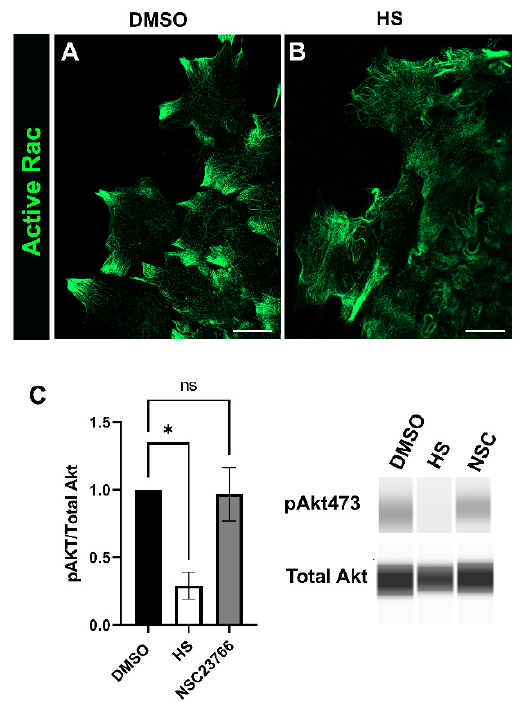
Figure 5. The link between Rac and PI3K signaling in promoting myofibroblast differentiation in response to injury. ( A , B ) Ex vivo post-cataract surgery explant cultures treated for 24 h from culture day 1 with either ( A ) the vehicle (DMSO) or ( B ) the p110 α inhibitor HS-173 immunolabeled for active Rac and imaged at the leading edge by confocal microscopy. In control cultures active Rac localized to protrusions extended by leader cells and this distribution was altered by treatment with HS-173. Images are presented as a single optical plane from the collected confocal z-stack with each optical plane at 0.33 µm. Magnification bar = 20 µm. ( C ) Ex vivo post-cataract surgery explants were treated with vehicle (DMSO), the Rac specific inhibitor NSC23766 (NSC) or the p110 α inhibitor HS- 173 (HS) on day 1 through day 2 post-injury and subjected to immunoblot analysis for pAkt and